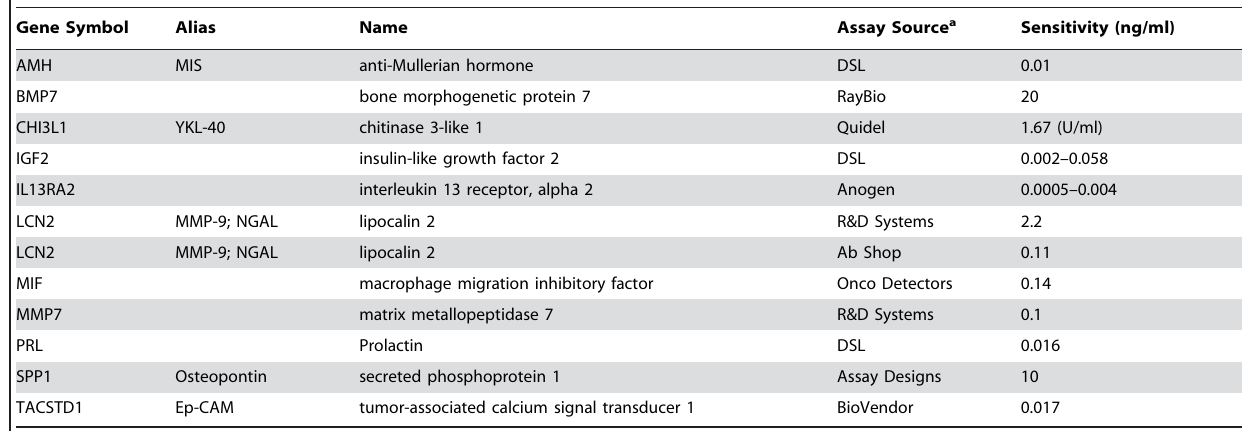
Table 6. Commercial ELISA reagents.